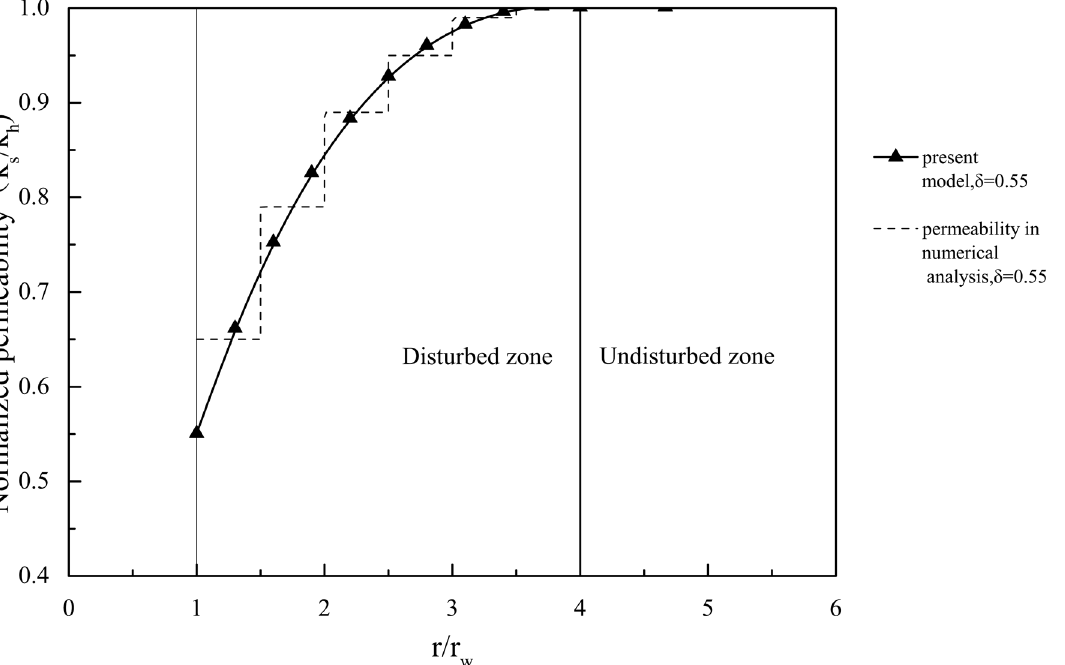
Fig 6. Permeability coefficient of the present model and the numerical analysis when δ =